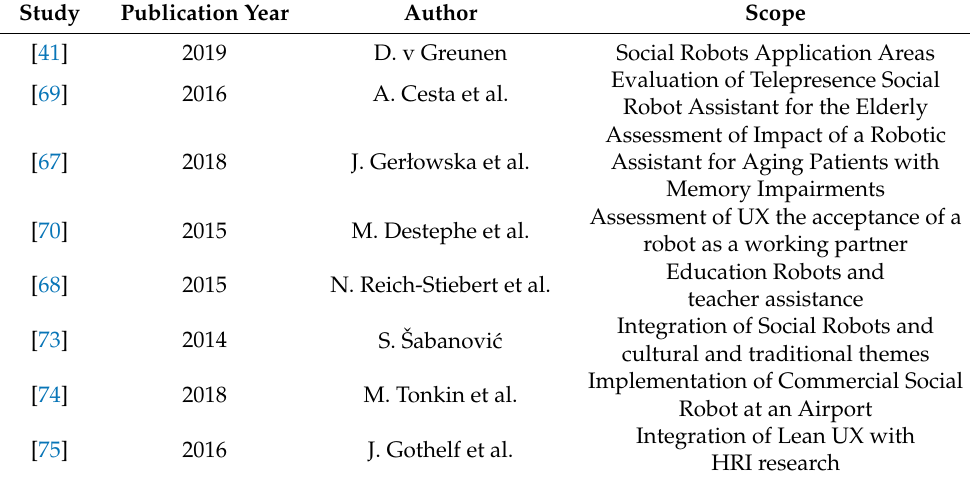
Table 1. Studies used to answer RQ 1